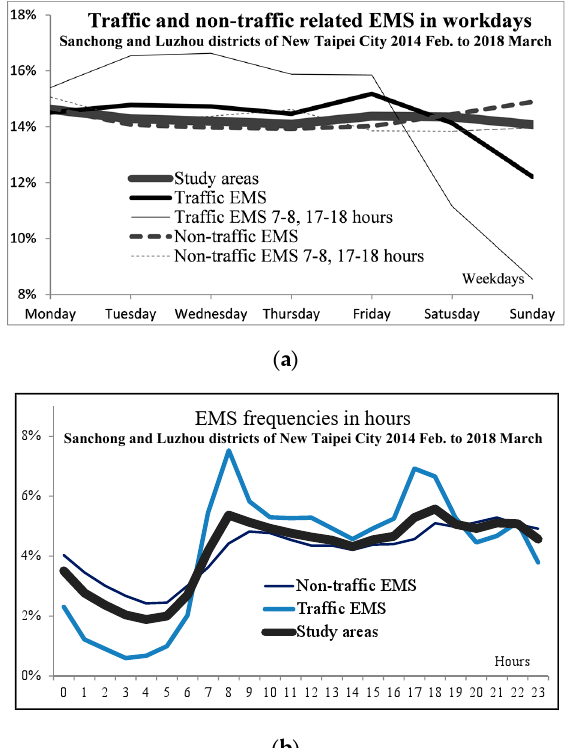
Figure 4. EMS incident frequencies for weekdays ( a ) and hours of the day ( b ) for Sanchong and Luzhou districts.